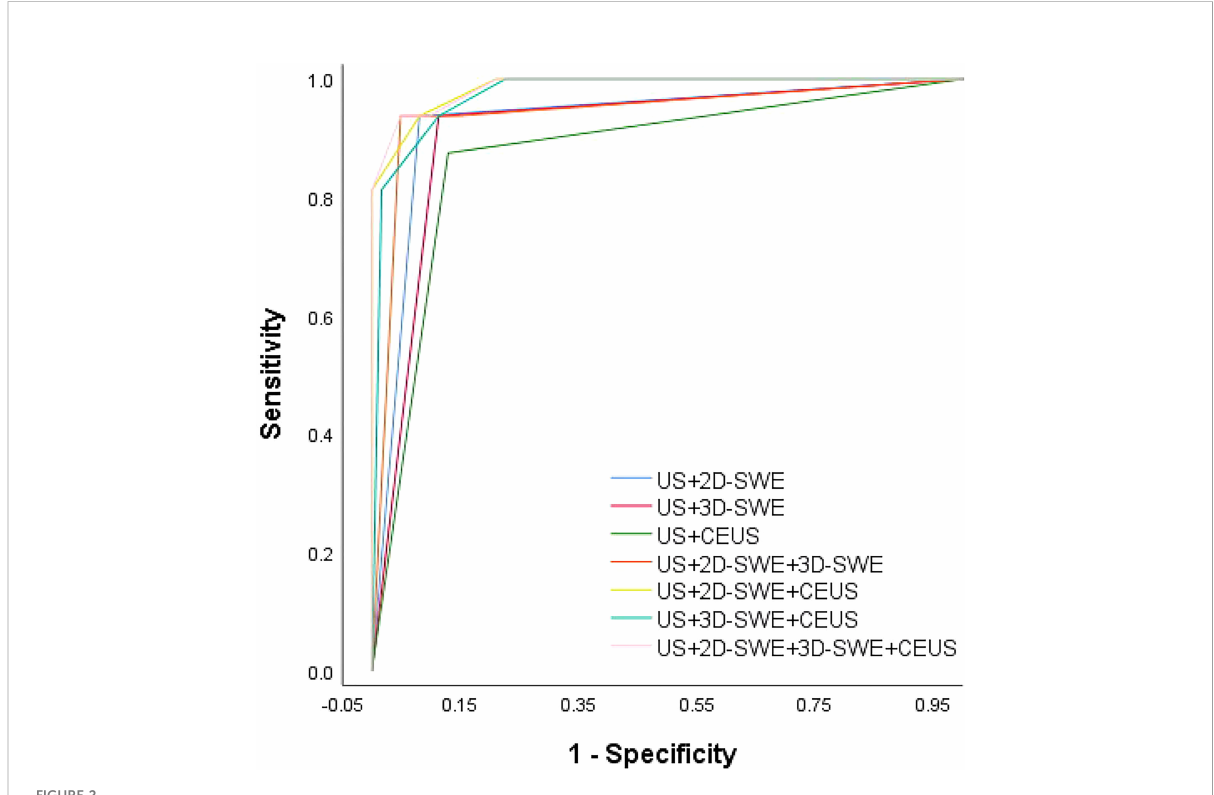
FIGURE 2 ROC curve of the multimode ultrasound